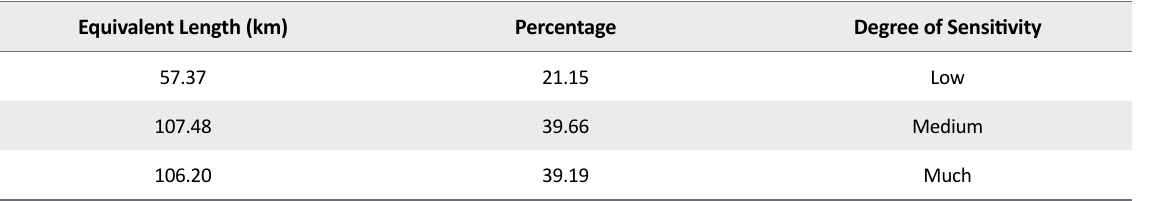
Table 4. Percentage of sensitivity categories in coastal strip Guilan Province to oil